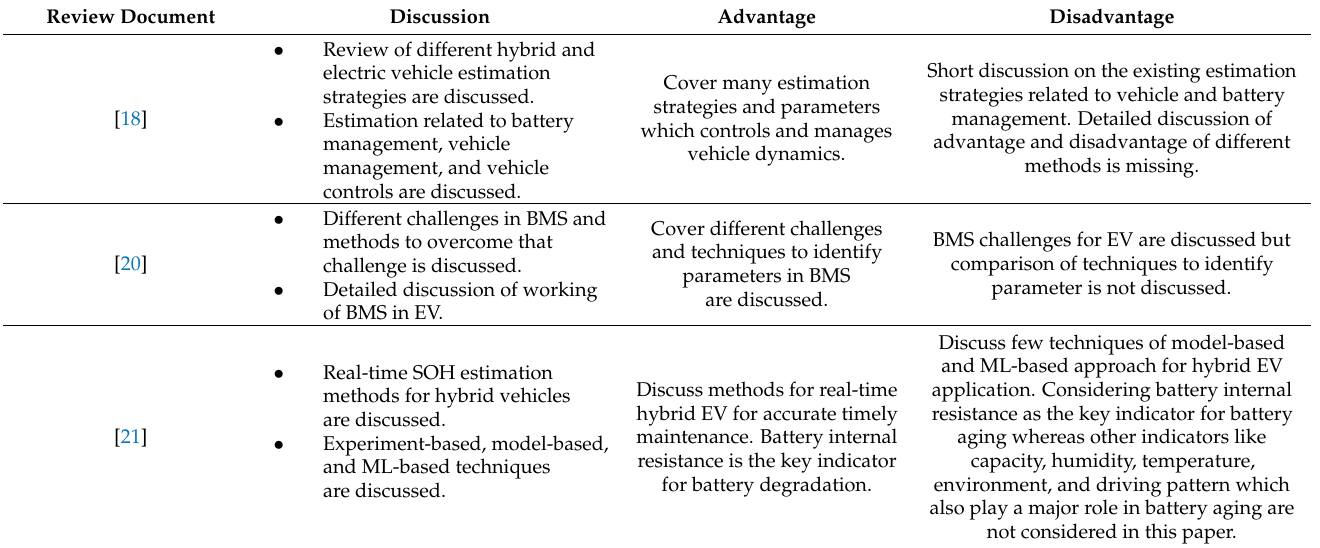
Table 2. List of the study related to review